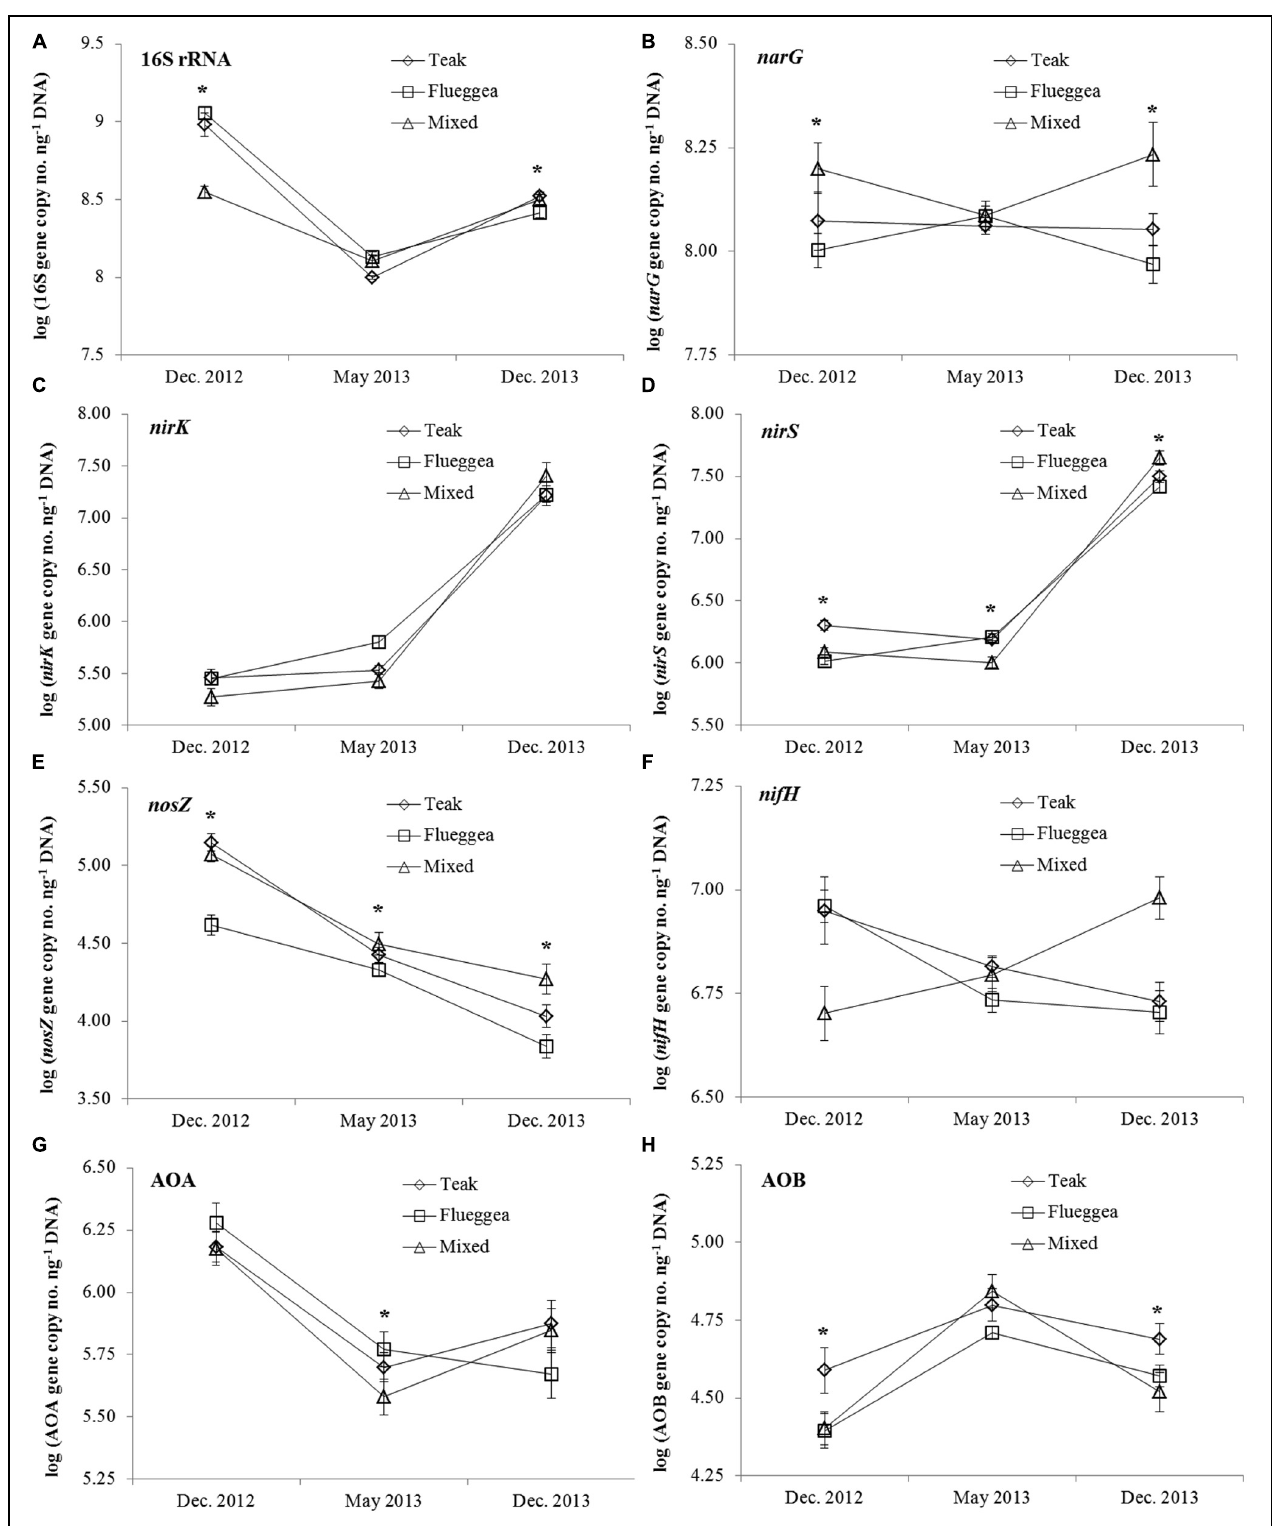
FIGURE 2 | Abundance of the total bacterial community (A) and of the narG (B), nirK (C), nirS (D), nosZ (E), nifH (F), AOA (G), and AOB (H) genes in soil under plantations of teak (diamonds), flueggea (squares), and mixed species (triangles) at three sampling dates. Gene abundances are expressed in log (gene copy numbers ng − 1 DNA). Asterisks indicate significant differences between plantation types (Tukey HSD test, P < 0.05).